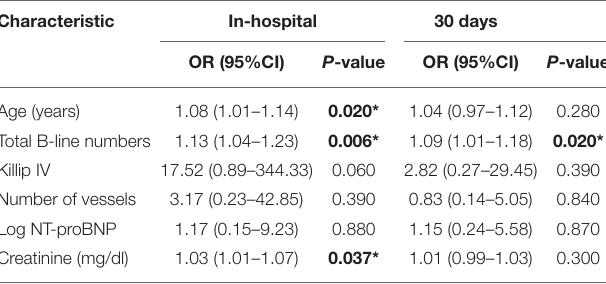
TABLE 3 | Multivariable analysis for in-hospital and 30 days composite outcome. Characteristic In-hospital